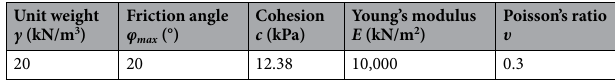
Table 1. Material properties of the numerical model .